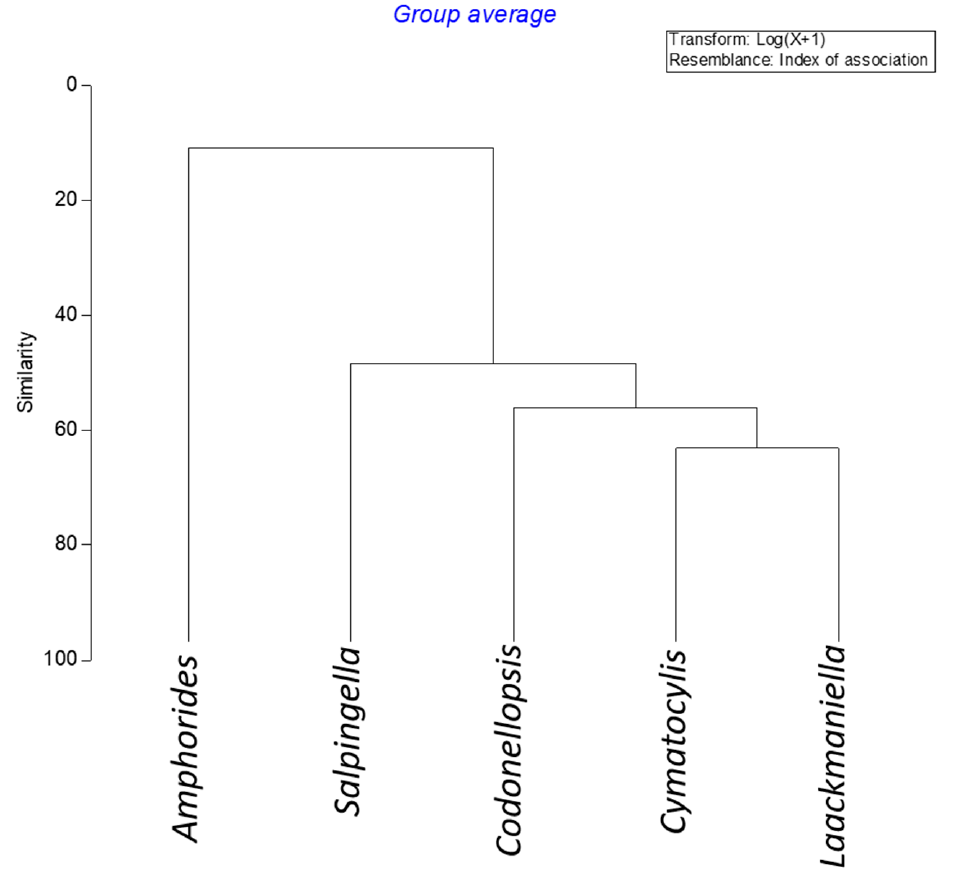
Figure 7. Cluster analysis on the index of association among genera.